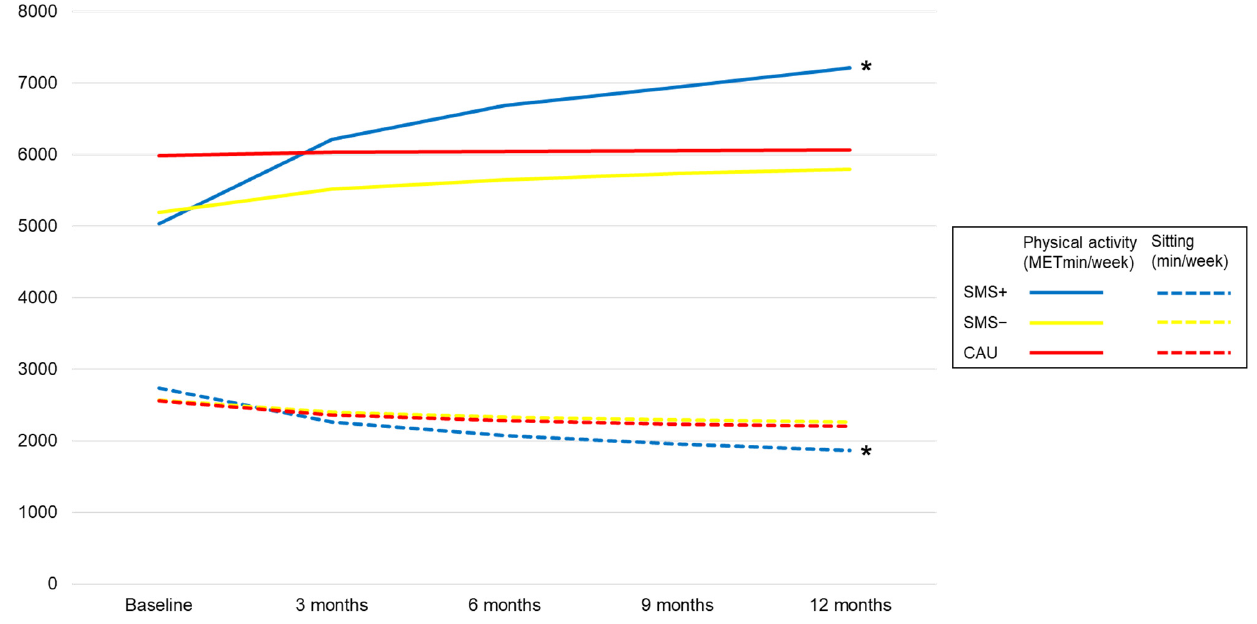
Figure 3. Changes in total physical activity METminutes and sitting behaviour minutes over time. Note: differences were tested with multilevel linear regression analyses, combined with a bootstrap procedure in case of a non-normal distribution. * indicates significant within-group differences ( p < 0.05). MET, metabolic equivalent of task; min, minutes; SMS+, lifestyle intervention with SMS support; SMS − , lifestyle intervention without SMS support; CAU, care as usual.